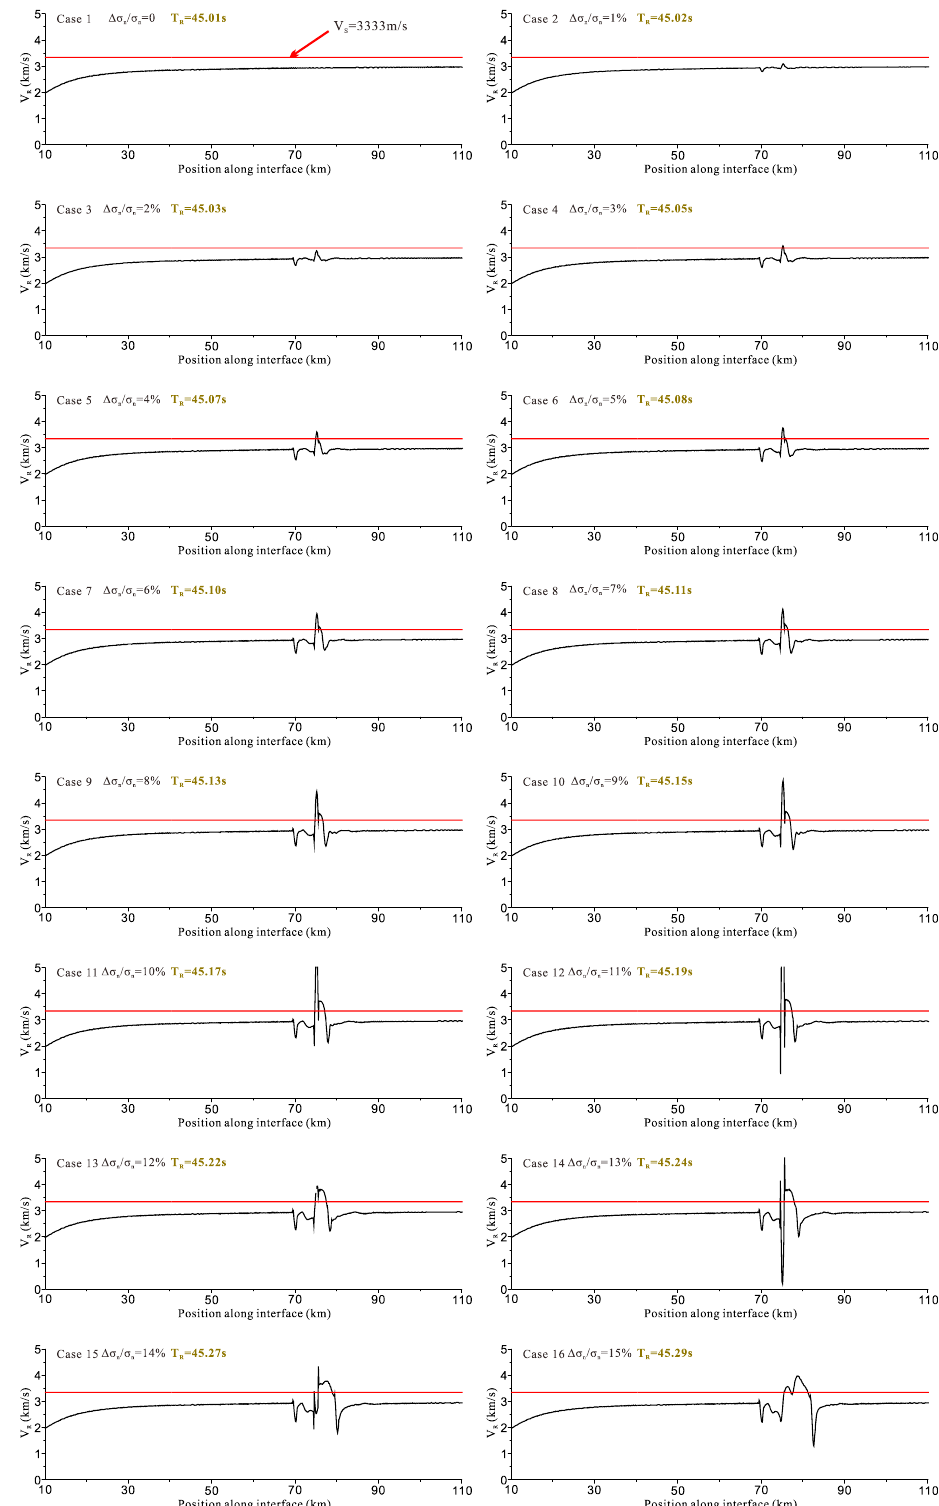
Figure 7. The distribution of rupture speed on the fault varies with barrier strength. The figure shows that near the barrier, the rupture speed of the fault first decreased and then rose. As the barrier strength increased, the curve of rupture speed on the fault fluctuated more and more.